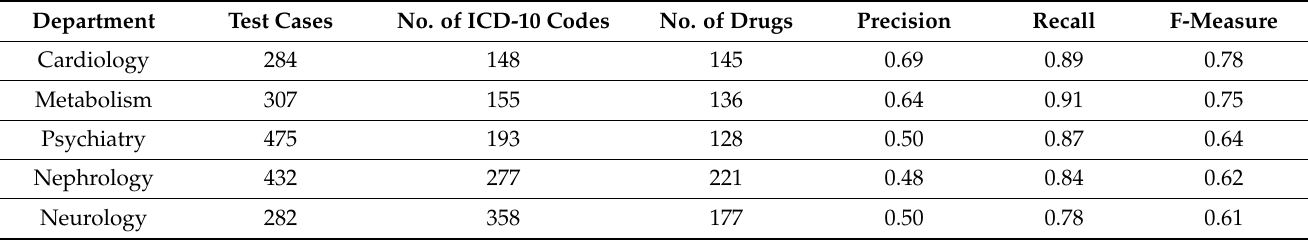
Table 2. Performance of CNN model for different